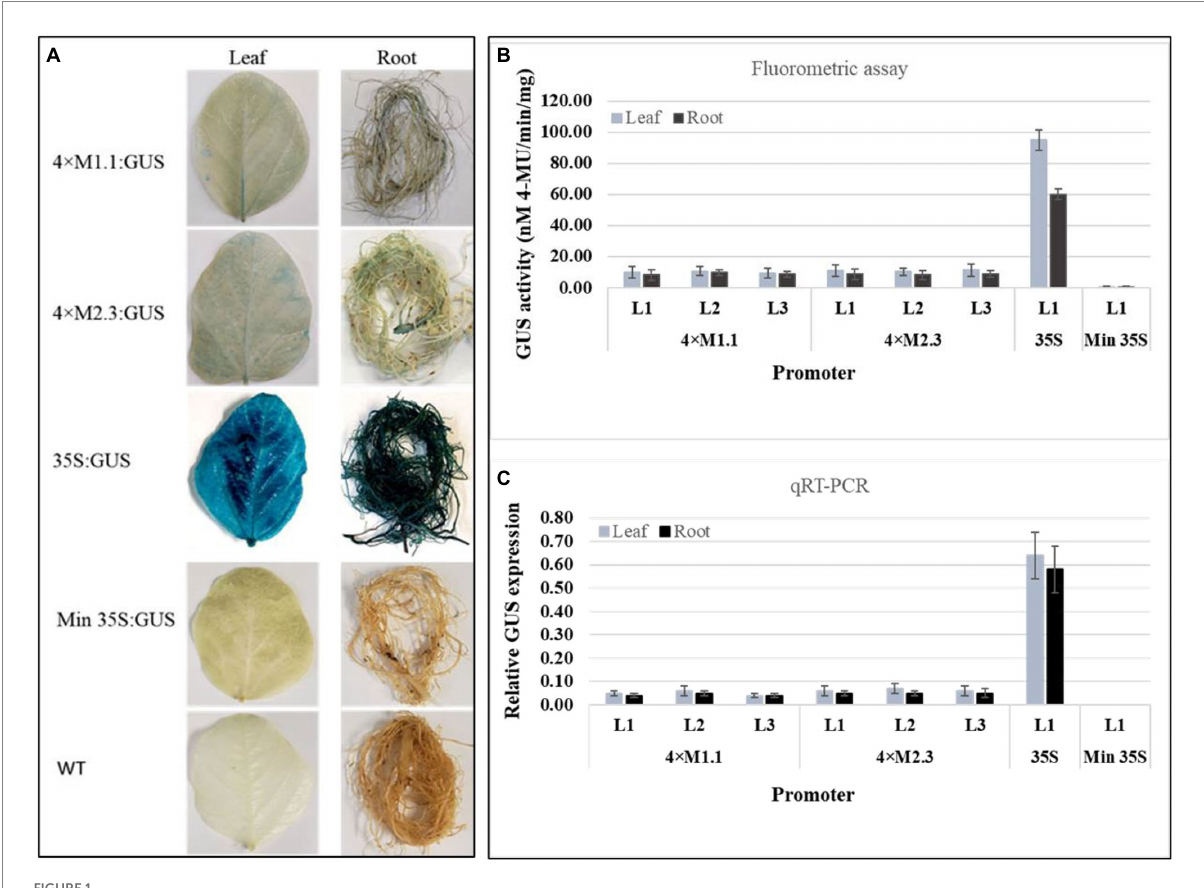
FIGURE 1 Basal GUS activity in leaves and roots of 3-week-old T 3 transgenic soybean containing the individual promoter-GUS construct under unstressed condition. (A) Histochemical staining for GUS activity in transgenic soybean and wild-type (WT) plants. (B) Fluorometric assay for GUS activity in transgenic soybean plants. (C) Quantitative real-time RT-PCR (qRT-PCR) analysis for GUS expression in transgenic soybean plants. The relative levels of transcripts were normalized to soybean ubiquitin gene ( GmUBI 3). Three independent transgenic lines (L1, L2, and L3) were used